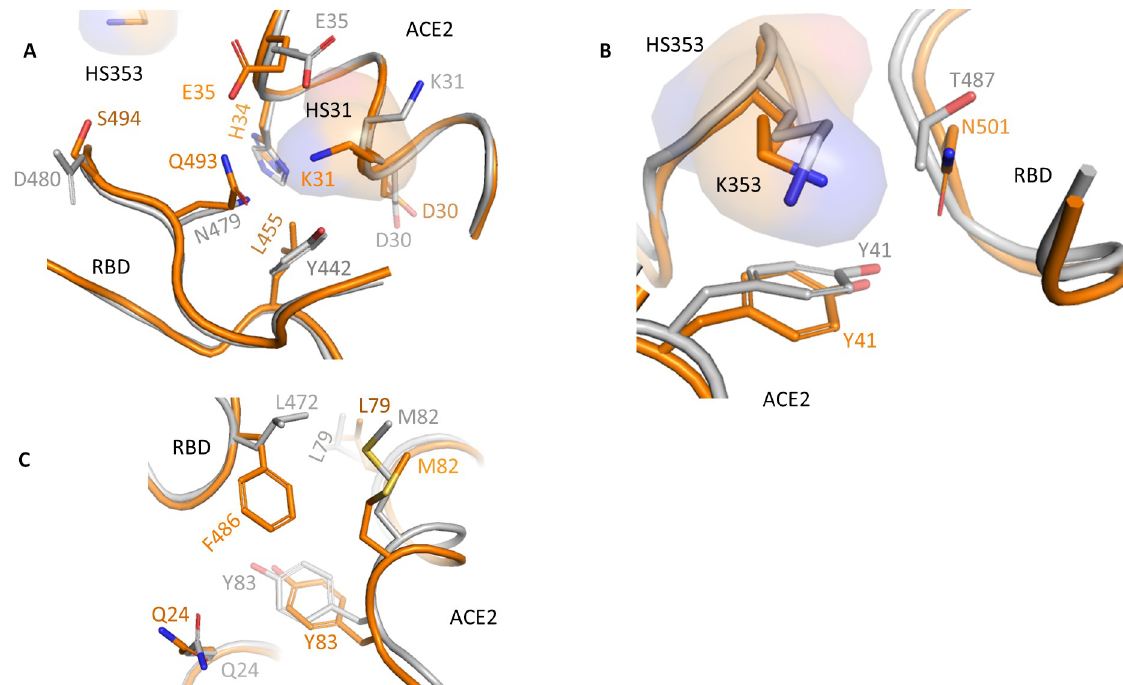
Fig 2. Interaction of SARS-CoV-2 RBD with human ACE2. The unique critical residues A) Leu455, Gln493 and Ser494 of SARS-CoV-2 RBD, B) Asn501 and C) Phe486 enables the SARS-CoV-2 RBD (orange) to interact with human ACE2 stronger compared to SARS-CoV (grey).